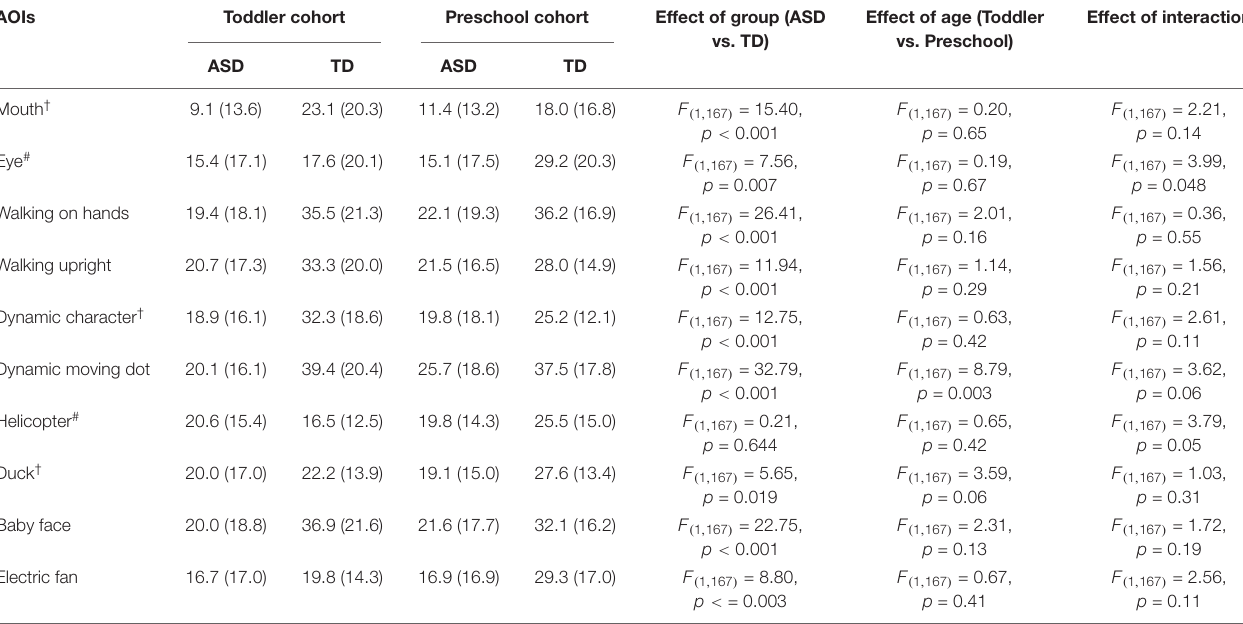
TABLE 2 | Fixation time percentage of the areas of interest